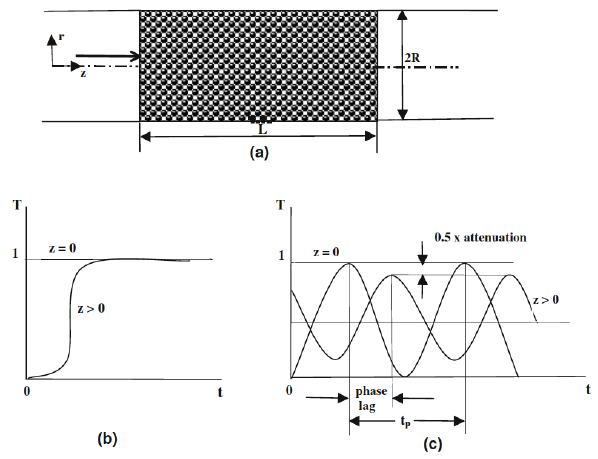
Figure 18. ( a ) Physical problem considered by Singh et al. [45] under ( b ) step and ( c ) oscillatory responses of boundary conditions.